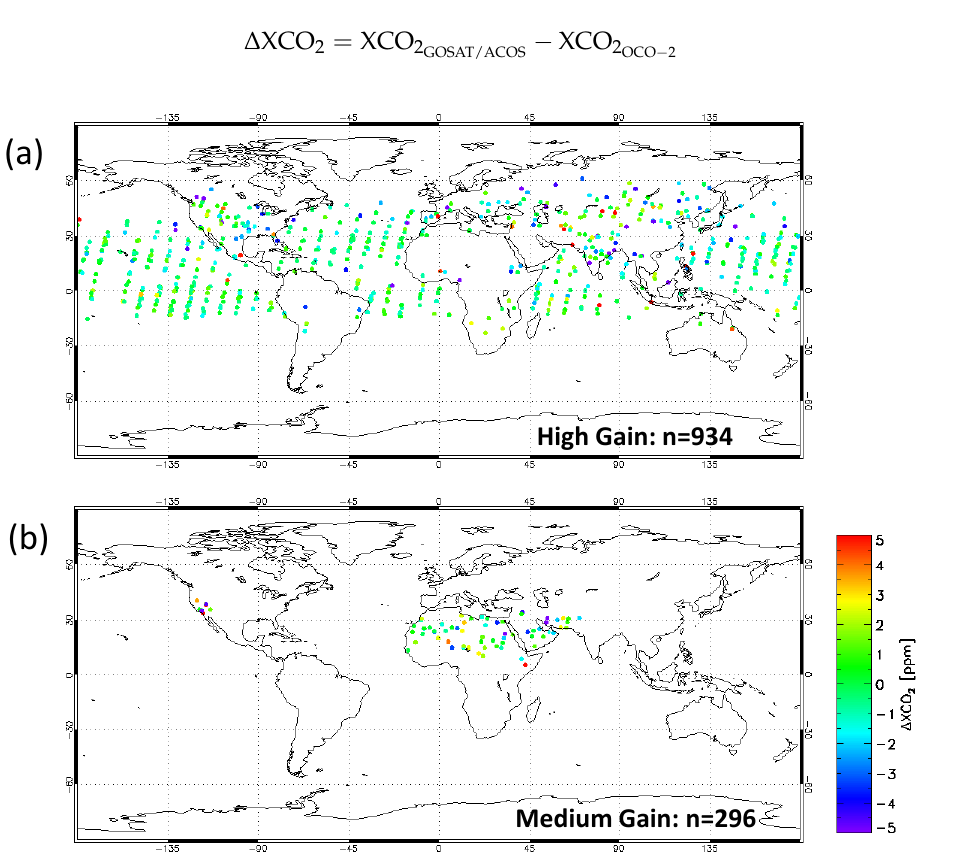
Figure 6. The plots show ∆ XCO 2 between GOSAT/ACOS and OCO-2 with ( a ) high gain and ( b ) medium gain observations.